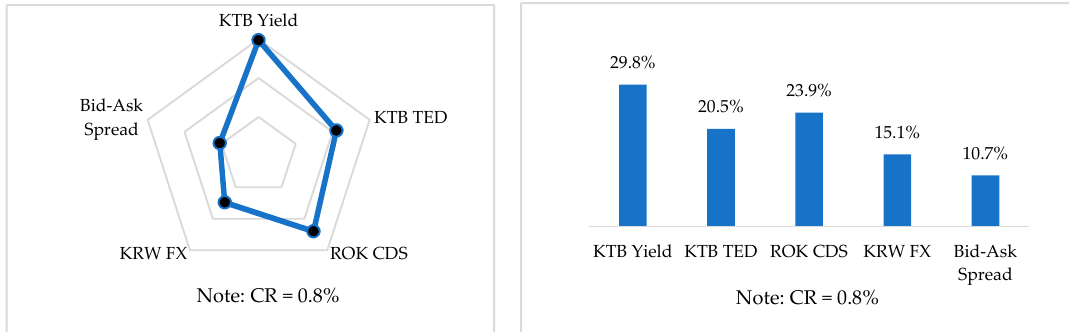
Figure 4. Local weights for domestic factors.